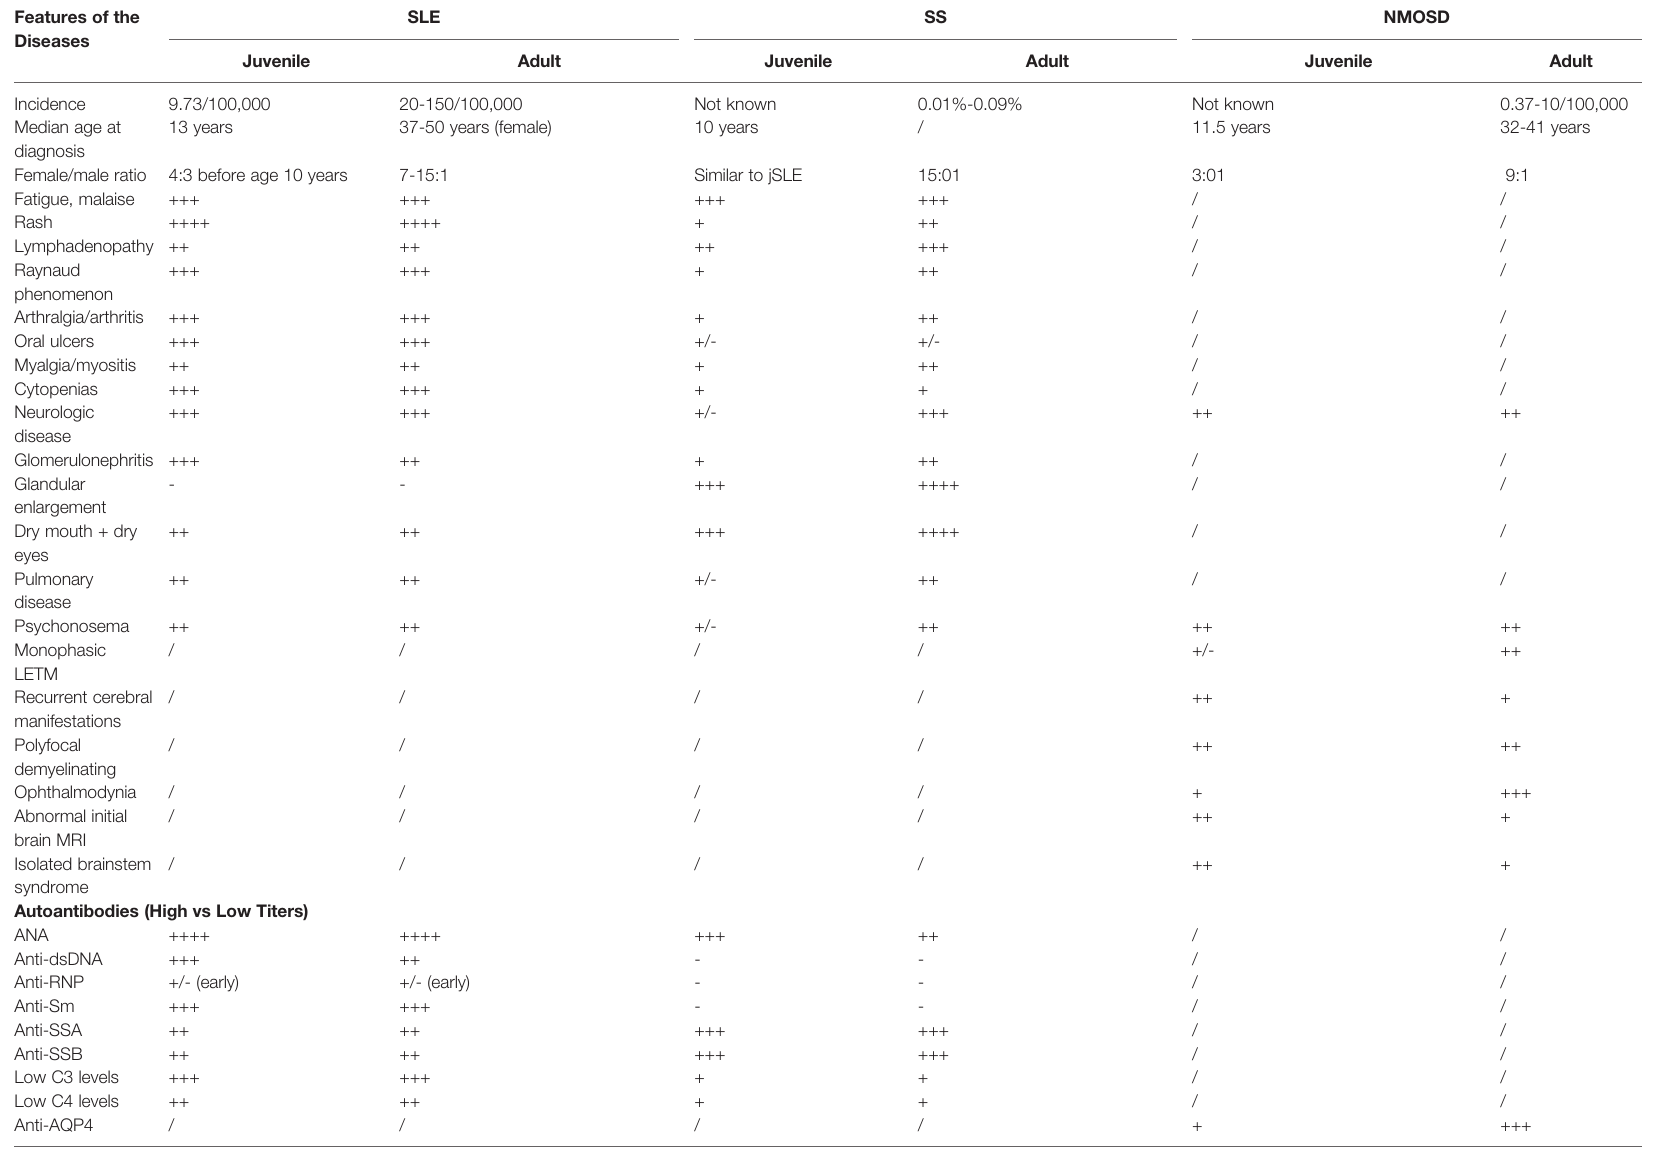
TABLE 2 | Differences between paediatric and adult patients with systemic lupus erythematosus, Sjogren ’ s syndrome and NMOSD. Features of the